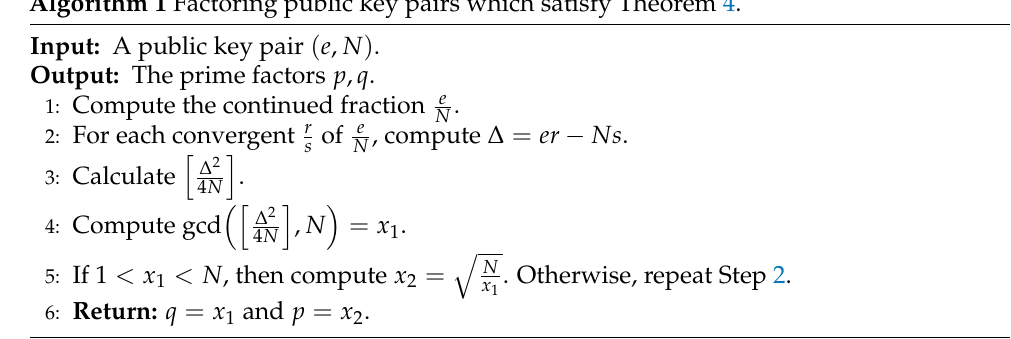
Algorithm 1 Factoring public key pairs which satisfy Theorem